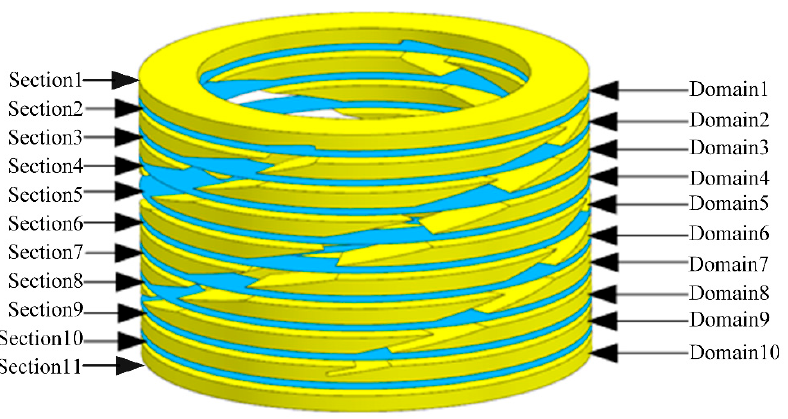
Figure 6. The division of the impeller domain.